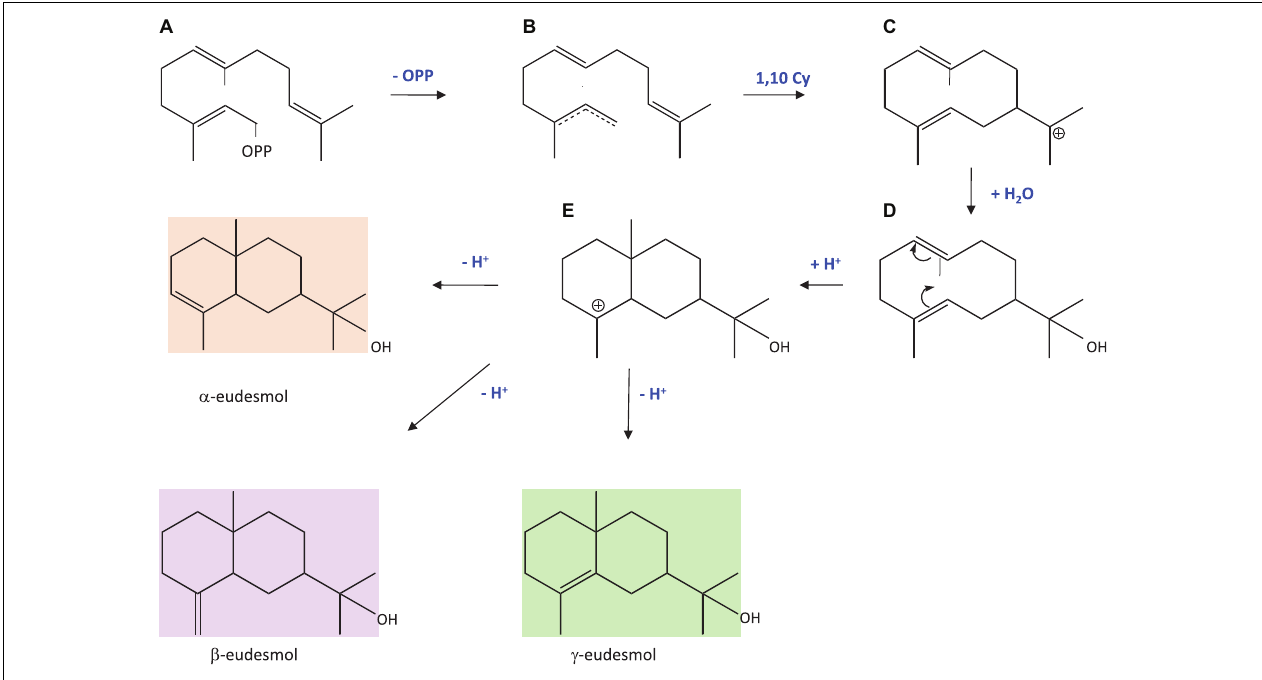
FIGURE 9 | Biosynthetic pathway leading to eudesmols modified from Rabe et al. (2016). (A) Farnesyl diphosphate; (B) farnesyl cation; (C) ( E,E ) germacradienyl, (D) hedycaryol; (E) eudesmol cation.